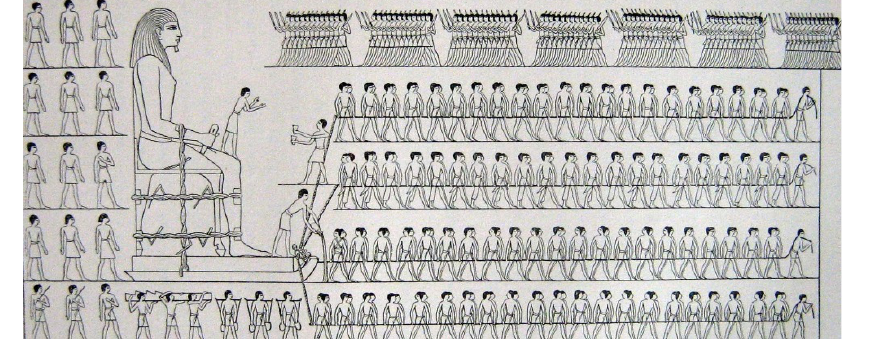
Fig. 5. Can you spot the first lubricant engineer? (Source: https://en.wikipedia.org/wiki/Djehutihotep#cite_note-davies-6) Just a nugget to illustrate. March 9th 2016 marked the 50th anniversary of the publication of the ground